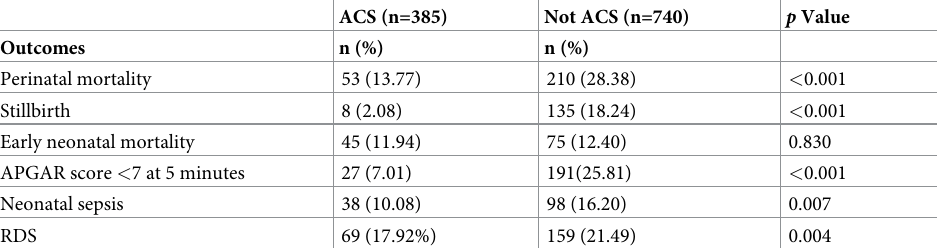
Table 2. Perinatal outcomes based on ACS exposure.